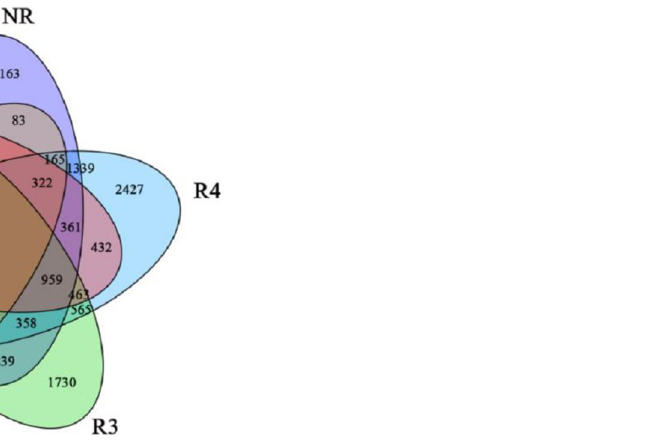
Fig 5. Venn diagram of gene expression in the five